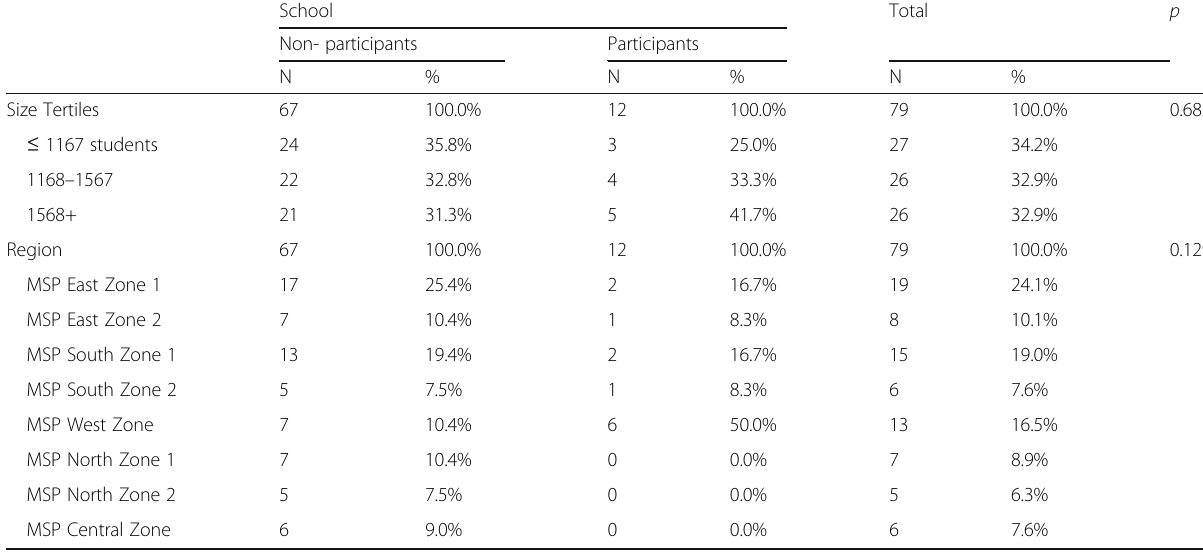
Table 1 Profile of the selected schools in the city of São Paulo in relation to the numbers of students and locations